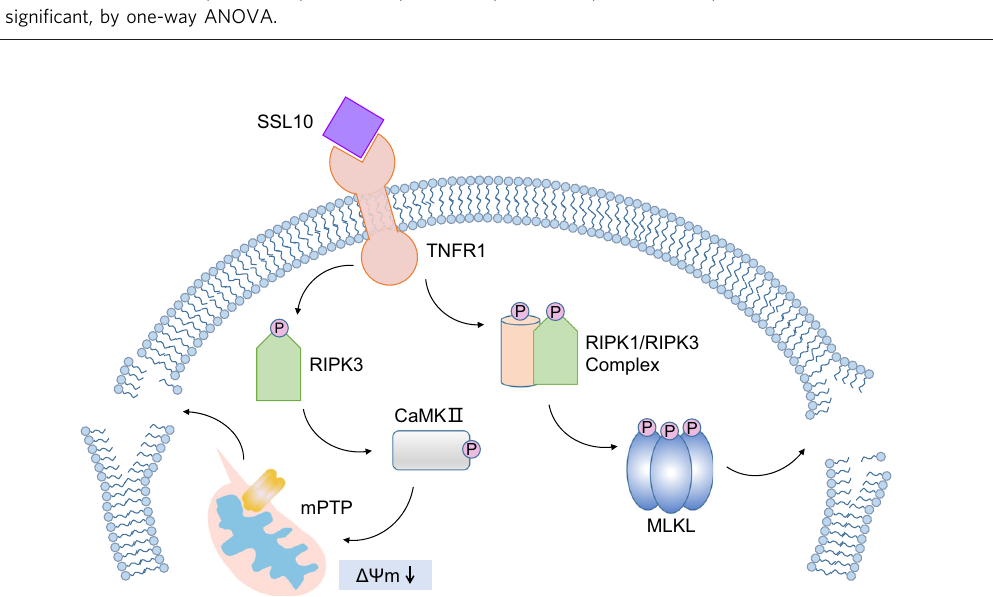
Fig. 7 Schematic diagram of the SSL10 signal cascade and subsequent cellular effects. SSL10 secreted by S. aureus directly interacts with TNFR1 on the host cell surface and induces cell necroptosis via two distinct pathways, including the RIPK1-RIPK3-MLKL and RIPK3-CaMKII-mPTP applied for fl ow cytometry analysis. The speci fi c gating strategies are listed in Supplementary Fig. 13. Knockout and rescue of ssl7 and ssl10 in S. aureus NCTC 8325 . To explore the effect of SSL10 on the cytotoxicity of S. aureus , ssl10 or ssl7 knockout strain was constructed using the vector pKOR1 51 . Brie fl y, ~1000bp fragment upstream and downstream, respectively, of ssl10 or ssl7 was cloned to pKOR1 via lambda recombination (BP clonase enzyme mix, Invitrogen). The resulting plasmid was transferred via electroporation fi rst to S. aureus RN4220 to modify DNA, and subsequently to S. aureus 8325. For homologous recombination and ingratiation of pKOR1 into the bacterial chromosome, S. aureus NCTC 8325 was grown at 43 °C on tryptic soy agar (TSA Cm10 ), a non-permissive condition for pKOR1 replication. From the resulting plate, one colony was picked, inoculated into 1ml TSB Cm10 and incubated at 30 °C overnight to facilitate plasmid excision. Cultures were then spread on TSA containing 200 ng/ml anhydrotetracycline and incubated at 30 °C overnight for selecting ssl10 or ssl7 knockout S. aureus NCTC 8325. To rescue ssl10 in ssl10 knockout strain, the gene sequence of ssl10 was ligated with hprk promoter and then cloned to the plasmid pOS1. The resulting plasmid was transferred via electroporation fi rst to S. aureus RN4220 to modify DNA, and subsequently to ssl10 -knockout S. aureus NCTC 8325. All strains were con fi rmed by Sanger sequencing (Sangon, Shanghai, China). Cytotoxicity assay of S. aureus ssl10 -knockout or rescue strains . WT, ssl10 or ssl7 knockout and rescue S. aureus NCTC 8325 strains were cultured in TSB medium (OXOID) for 8h at 37 °C, 220 rpm. The same number of bacteria cells were inoculated into a new tube of TSB medium respectively, and cultured over- night at 37°C, 220 rpm for protein expression and secretion. Bacteria cells were collected after achieving stagnate phase and the supernatants were obtained by centrifugation at 5000 rpm for 15 min at room temperature. After fi ltration with a 0.22 μ m fi lter, the supernatants were used to treat HEK293T or HUVEC cells for 48h after 1:10 dilution with Opti-MEM reduced serum medium, and LDH released from the cells were determined. The level of LDH released was expressed as the fold of the control group (TSB medium-treated cells) after subtracting the background absorbance. RIPK3 knockout cells were transiently transfected with the RIPK3-expression